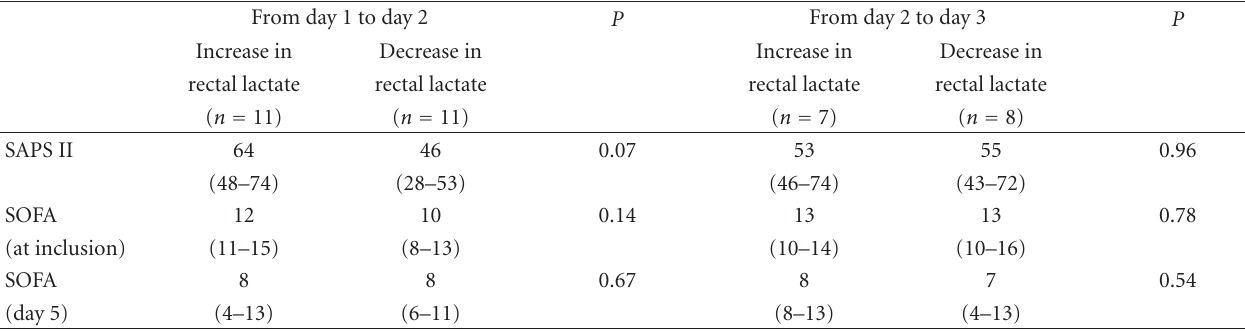
Table 3: SAPS II score, SOFA score at inclusion and day 5 of patients with an increase or decrease/no change In luminal rectal lactate from day 1 to day 2 or from day 2 to day 3,